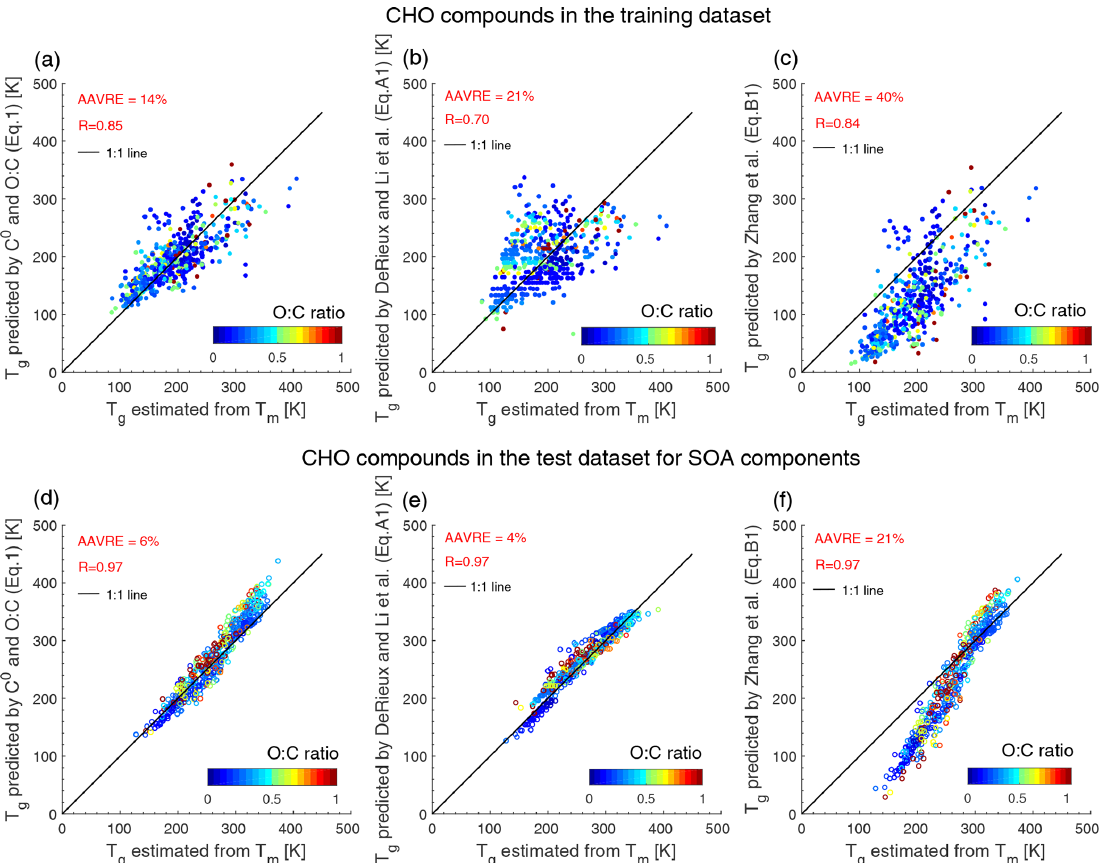
Figure B2. Predicted T g by (a) C 0 and O : C (Eq. 1), (b) elemental composition (Eq. A1), and (c) the parameterization (Eq. B1) in Zhang et al. (2019) plotted against estimated T g from T m applying the Boyer–Kauzmann rule. CHO compounds in (a) – (c) included in the training dataset shown in Fig. 1a are with measured T m and C 0 values; CHO compounds in (d) – (f) included in the test dataset for SOA components shown in Fig. 1c are with T m and C 0 values estimated by the EPI Suite and the EVAPORATION model, respectively. The correlation coefficient ( R ) and the average absolute value of the relative error (AAVRE) are